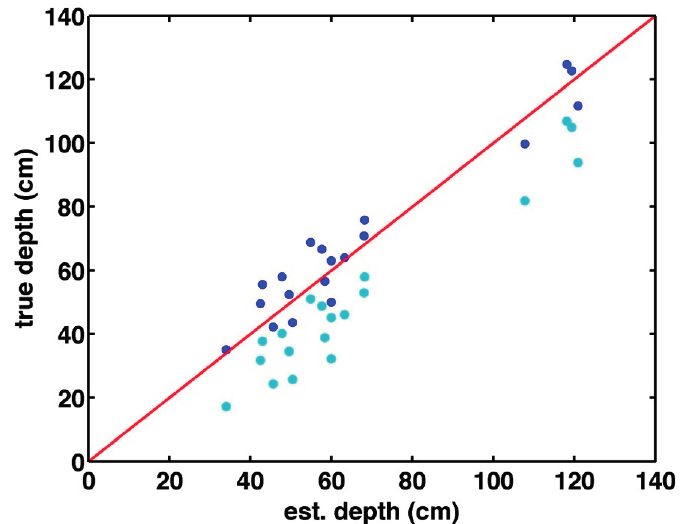
Figure 8. Scatter plot of the observed snow depth vs. estimated snow depth calculated using the direct BA techniques. The cyan dots represent the original estimated snow depths (with bias), whereas the blue dots represent snow estimates when the affine transformation is applied. The RMSE was 18.4 cm with using only onboard GPS; after the transformation was applied, the RMSE is 8.8